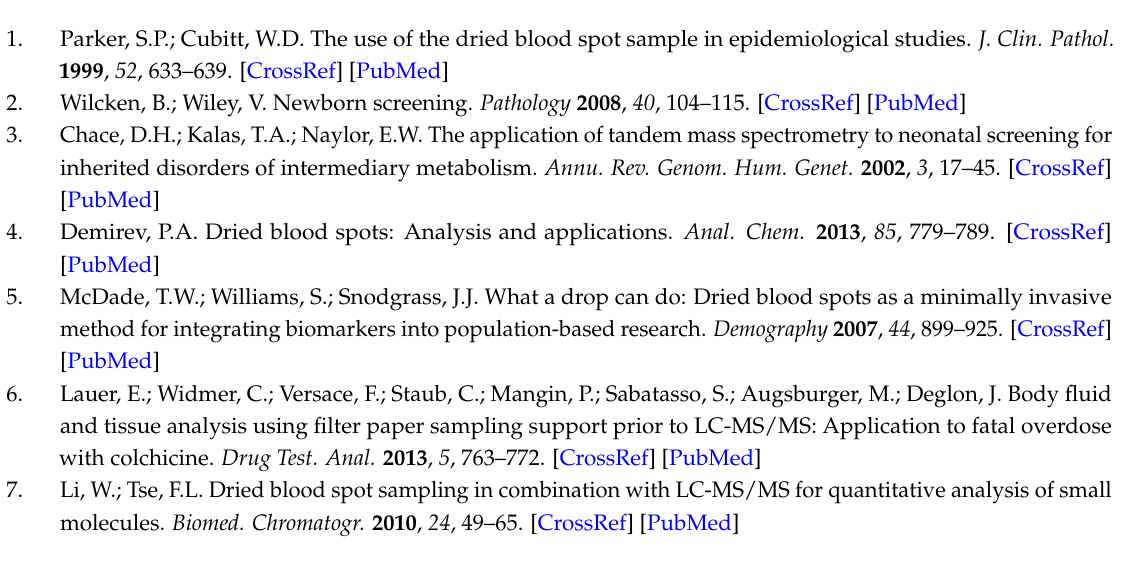
Table S1: Impacted human blood metabolites in different matrices, Table S2: Impacted human urine metabolites in DUS, Figure S1: GC-TOF-MS mass chromatograms, Figure S2: Hierarchical clustering analysis results of two weeks DBS storage stability